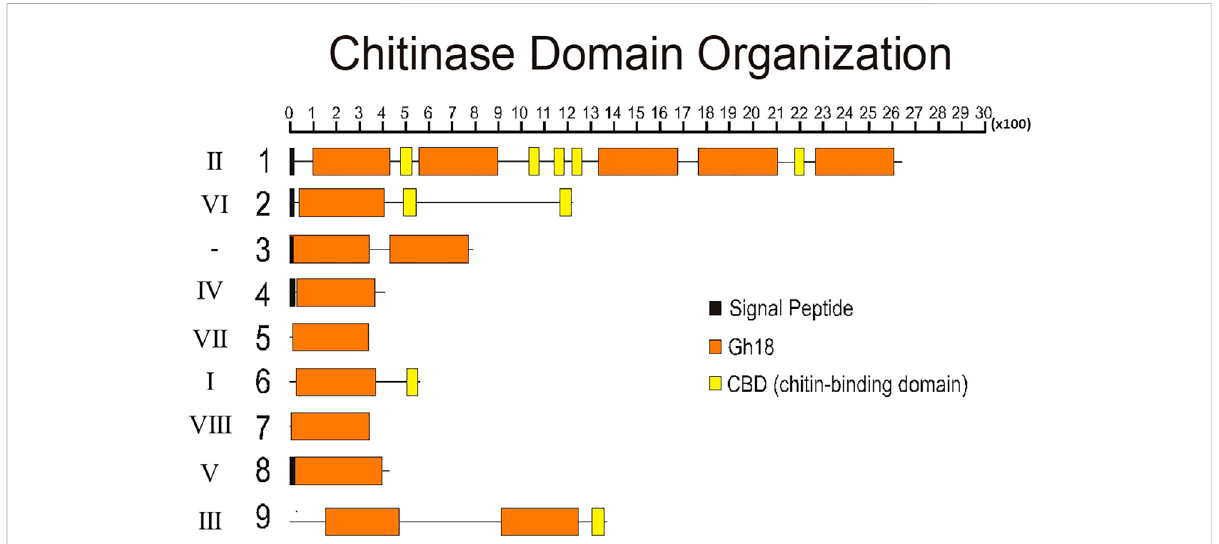
FIGURE 2 Schematic diagram of the domain architecture of chitinases from R. prolixus . Signal peptides are boxed in black, catalytic domains boxed in orange, and chitin-binding domains boxed in yellow. Numbers 1 – 9 represent proteins RpCht1-9, respectively. Roman numbers represent chitinase families. x100 = lenght of chain, in aminoacid